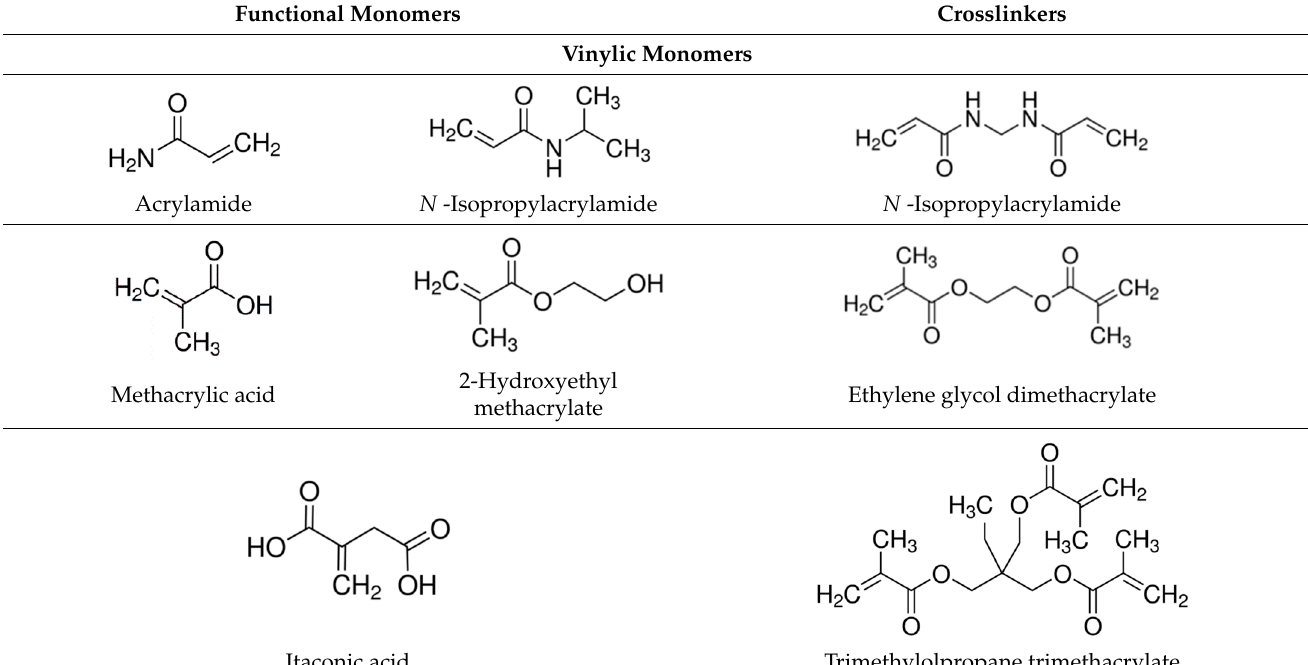
Sensors 2021 , 21 , 4300